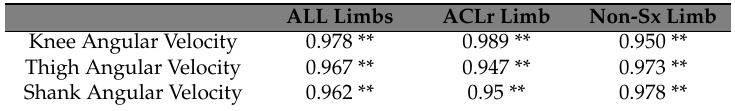
Table 2. Intraclass correlation coefficients (2,k) between marker-based motion capture and inertial sensor measurements for peak knee angular velocity, and peak thigh and shank angular velocities measured in all limbs, the reconstructed (ACLr) and nonsurgical (Non-Sx) limb. ALL Limbs ACLr